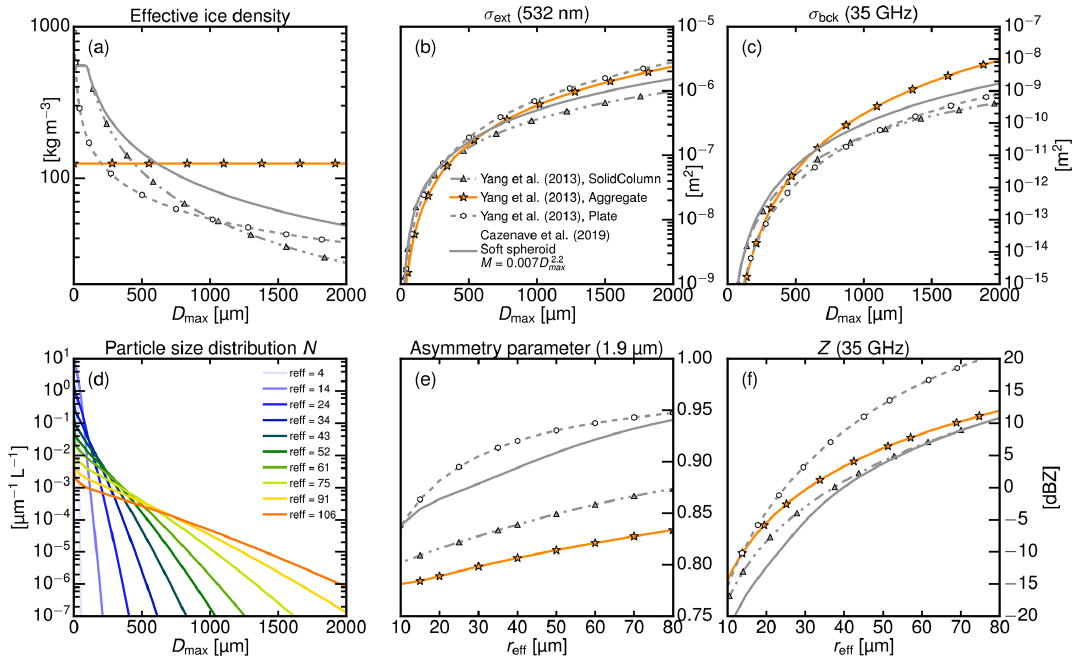
Figure 3. Microphysical, single-scattering, and bulk radiative properties of the different ice crystal models used in this study (gray line: soft spheroid approximation following Cazenave et al., 2019; symbol lines: specific ice crystal shapes following Yang et al., 2000). (a) Relationship between maximum dimension D max and effective ice density for single ice crystals in kgm − 3 , (b) extinction cross-section σ ext at 532nm, and (c) radar backscatter cross-section σ bck in square meters. (d) Particle size distributions of Cazenave et al. (2019) for different effective radii and corresponding (e) asymmetry parameter at 1 . 9µm and radar reflectivity Z at 35GHz for an ice cloud with constant IWC = 1gm − 3